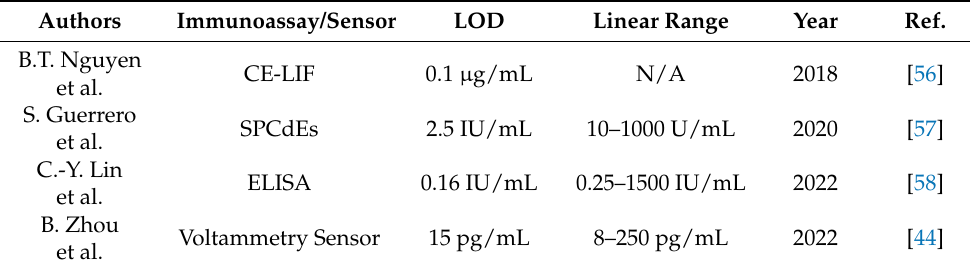
Figure 7. The mean variation and standard deviation in the ( a ) resonant wavelength shift and ( b ) transmission loss detected by the TFBG sensor after 10 min PBS immersion and 4 min CCP immersion. ( c , d ) Pre-immune CCP concentration of 162.5 ng/mL 1 cycle and 2 cycle spectrum graphs, respectively. ( e , f ) Pre-immune CCP concentration of 180 ng/mL 1 cycle and 2 cycle spectrum graphs, respectively. ( g , h ) Pre-immune CCP concentration of 150 ng/mL 1 cycle and 2 cycle spectrum graphs, respectively. ( i , j ) Pre-immune CCP concentration of 187.5 ng/mL 1 cycle and 2 cycle spectrum graphs, respectively. Table 1. CCP biomedical immunoassay literature